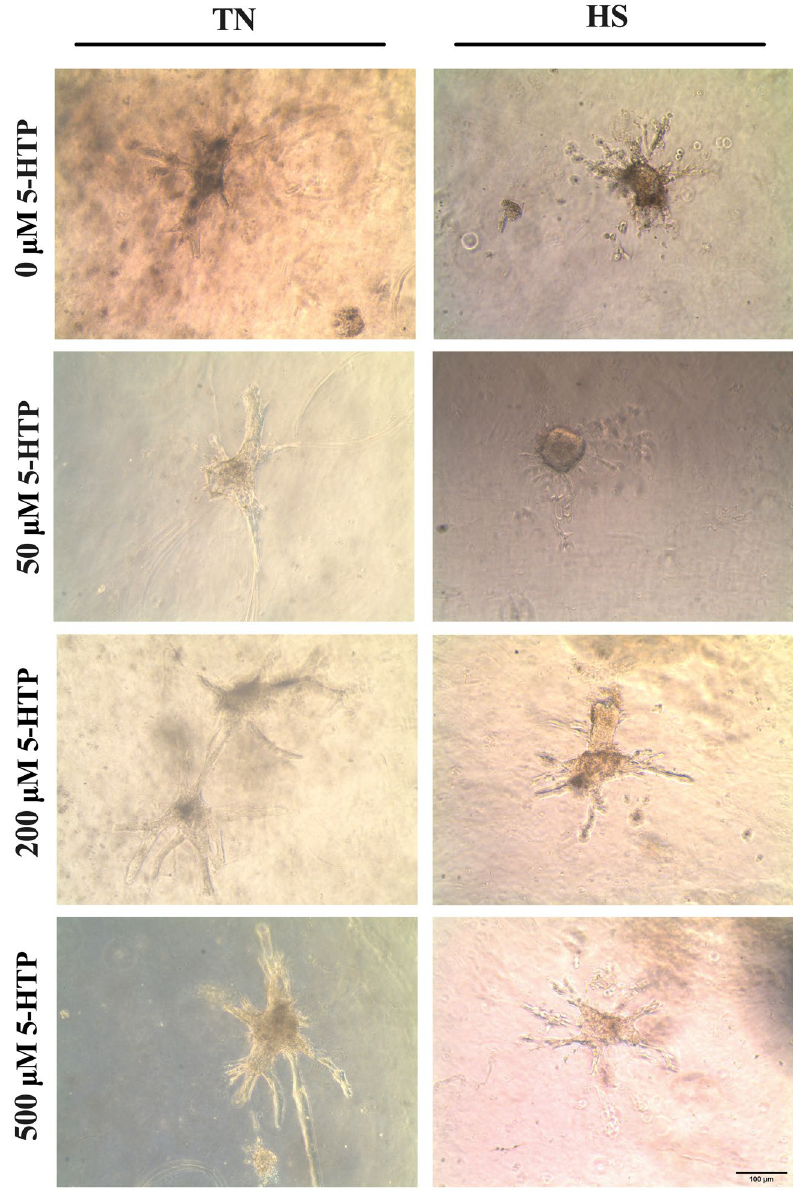
Figure 6. Photomicrographs of primary bovine mammary epithelial cells (pBMEC) on collagen gel cultures. Following a 24-h exposure to 0, 50, 200 or 500 μM dose of 5-Hydroxy-L-tryptophan (5-HTP) at either thermoneutral (37 °C, TN) or heat shock (41.5 °C, HS) with 5% CO 2 culture condition. Photomicrographs were taken to visualize and quantify branch number and morphology (i.e., branch diameter and length). Scale bar indicates 100